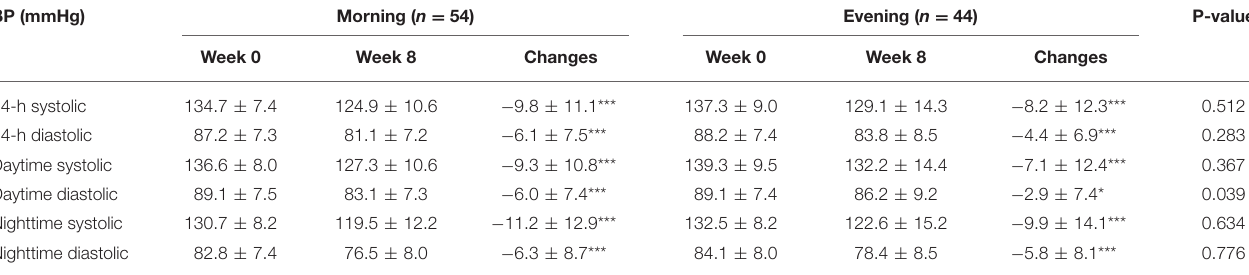
TABLE 4 | Comparison of ambulatory BP reduction between morning or evening dosing.